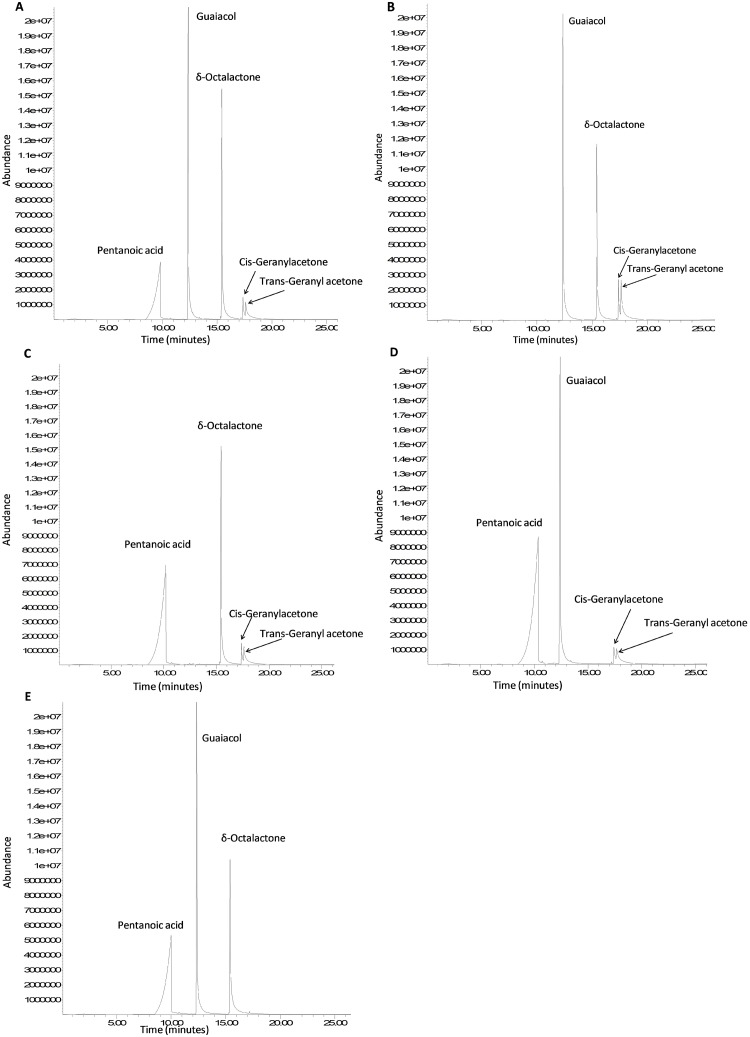
Total ion chromatograms.WRC (A), WRC without pentanoic acid (B), WRC without guaiacol (C), WRC without δ-octalactone (D) and WRC without geranylacetone (E).